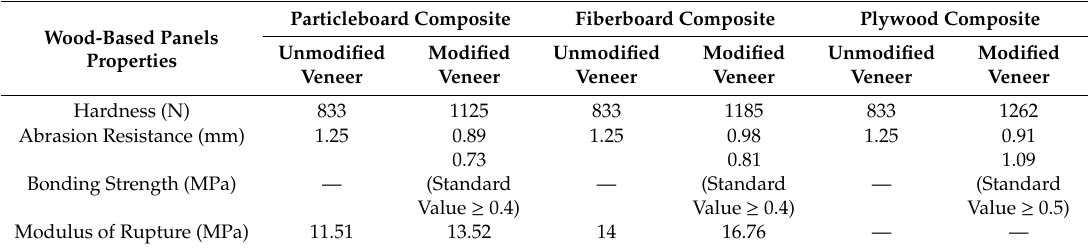
Table1. Comparisonofthesurfacepropertiesofalltheveneer-decoratedwood-basedpanelcomposites[ a ]. Table 1. Comparison of the surface properties of all the veneer-decorated wood-based panel Wood-Based Panels composites[ a ].